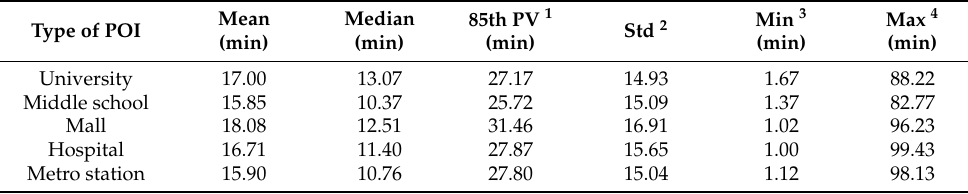
Table 3. Statistics of vehicle usage duration at PB stations at different POIs.